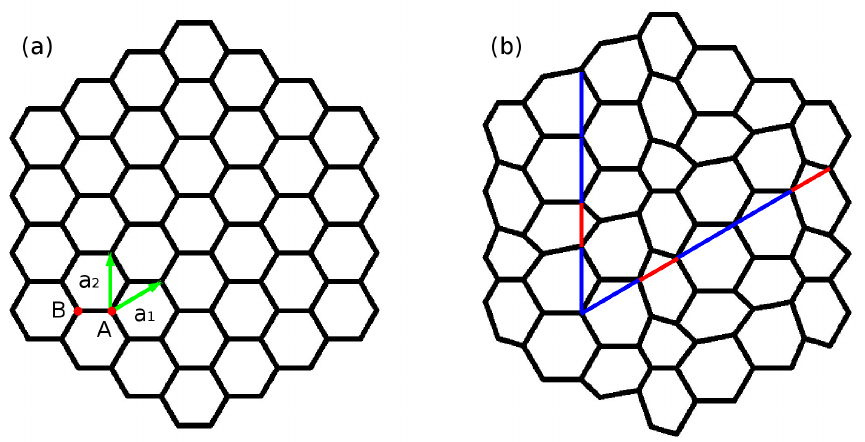
Figure 1. ( a ) Unperturbed Kagome artificial spin ice (ASI), limited to the 3rd generation (i.e., having 37 hexagons in total). Black regions denote ferromagnetic material. The primitive vectors of the underlying Bravais lattice a 1 and a 2 are also shown; A and B denote the basis positions; ( b ) Distorted network with r = L / S = 1.50, which illustrates the modified lengths along the primitive directions, L (blue) and S (red). The Fibonacci word for this example is: LSLLS